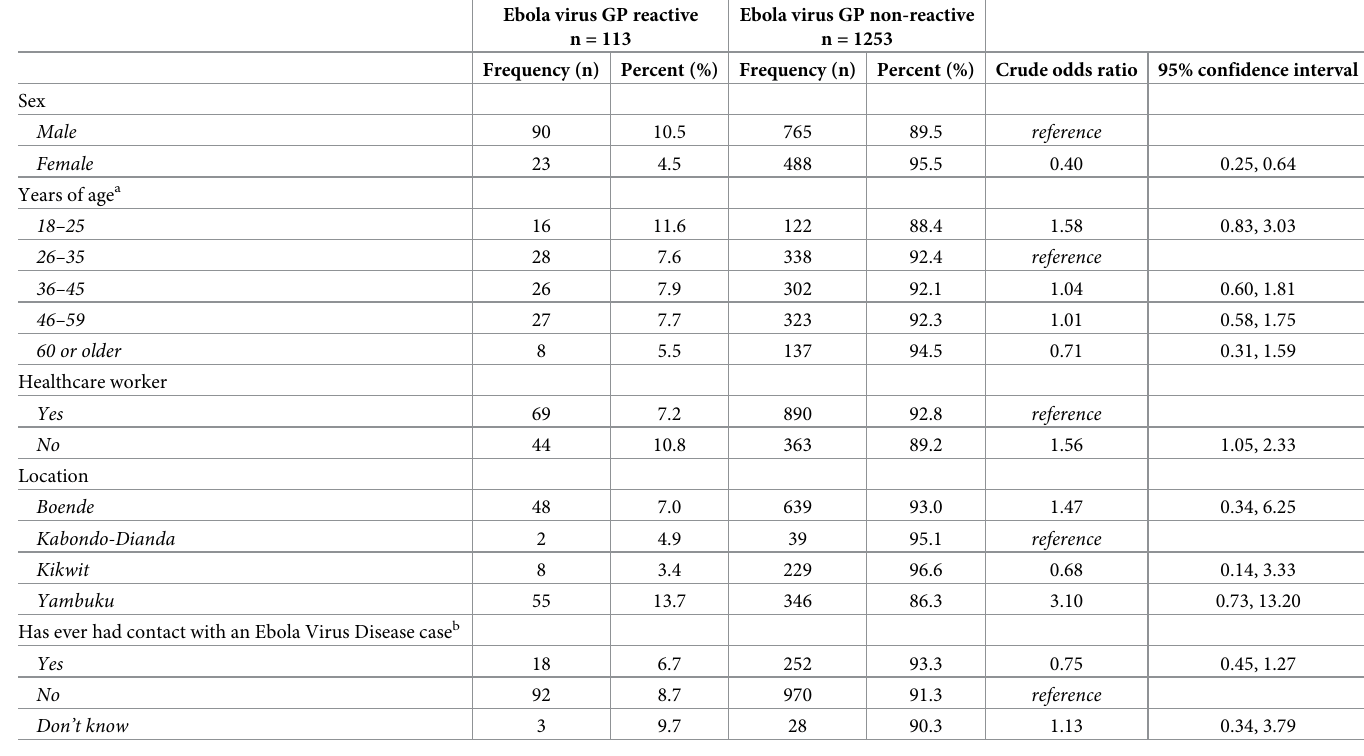
Table 2. Seroreactivity to Ebola virus GP by select characteristics among 1,366 individuals from Boende, Kabondo-Dianda, Yambuku, and Kikwit in the Democratic Republic of the Congo,